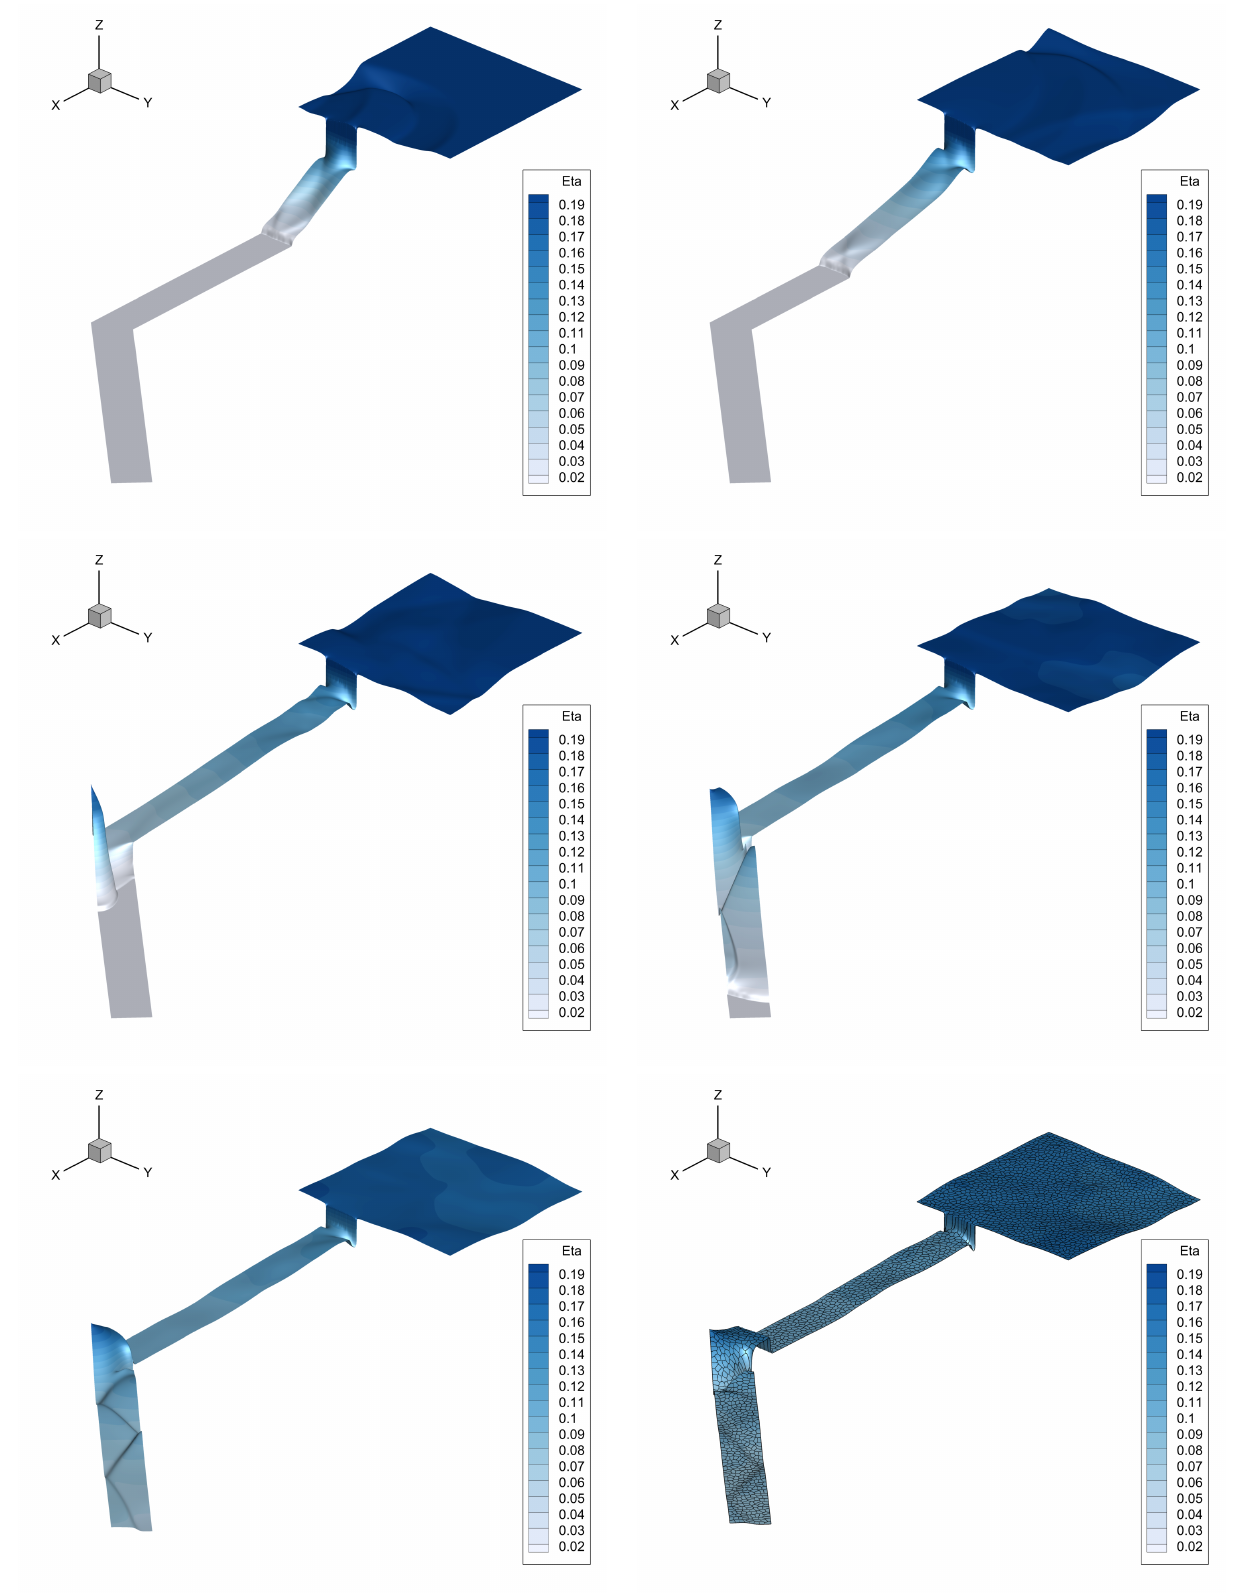
0.5,1.0,2.5,4.0,6.0,8.0 . Right bottom ∈ { }